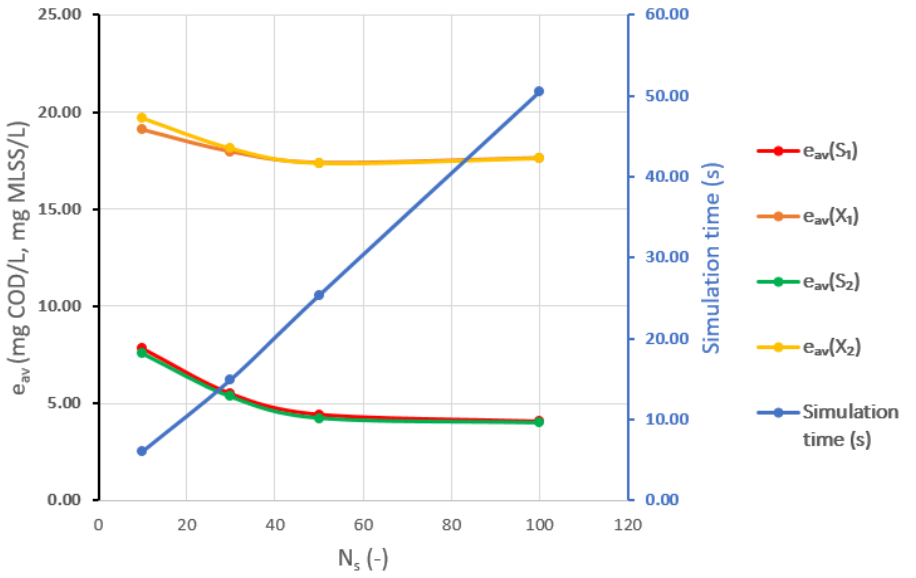
Figure 6. The average estimation (absolute) errors ( e av ) and the simulation time for different numbers of particles ( N s ). N S = 10, 30, 50, and 100 were simulated. The presented simulation times refer to the duration of one simulation ( T = 4000). The number of simulations is N r =